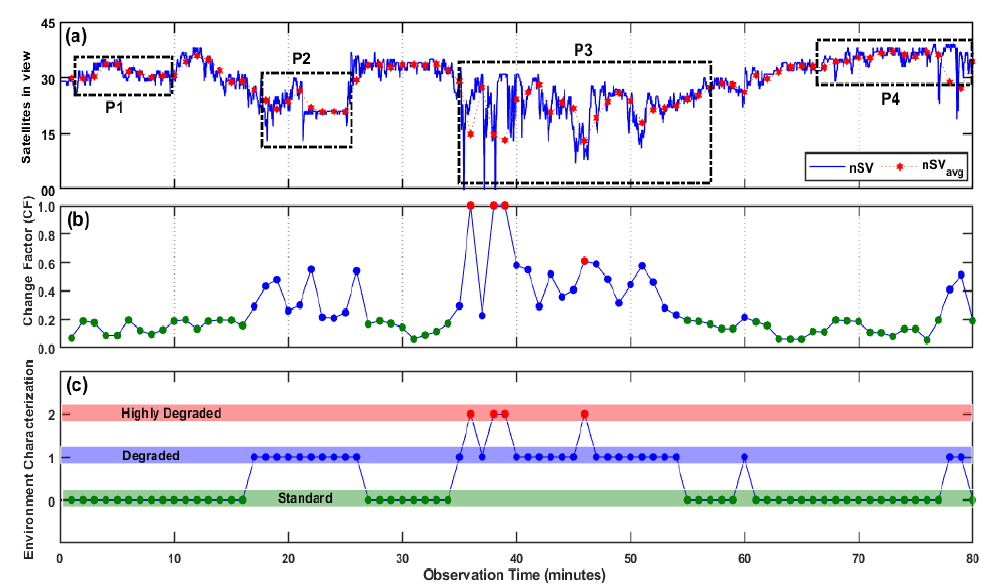
Figure 7. Environment context detection and categorization using CAN based on nSV avg and CF parameter values. ( a ) Satellites in view, ( b ) Change Factor (CF) and ( c ) Environment